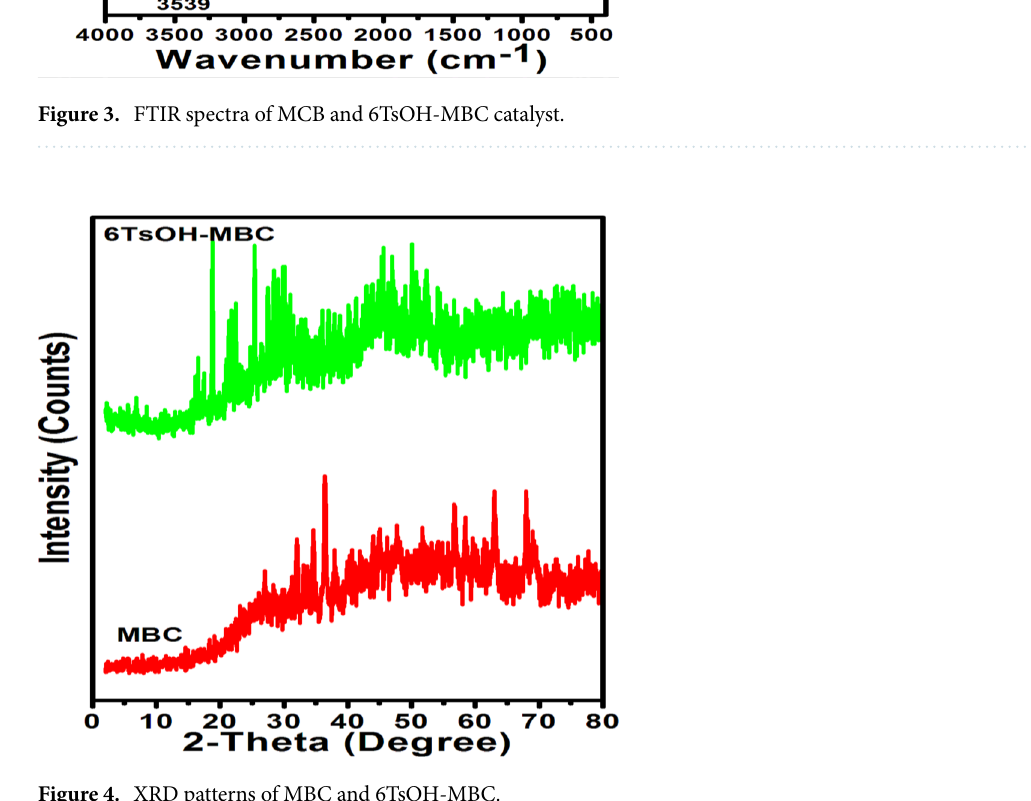
Figure 4. XRD patterns of MBC and